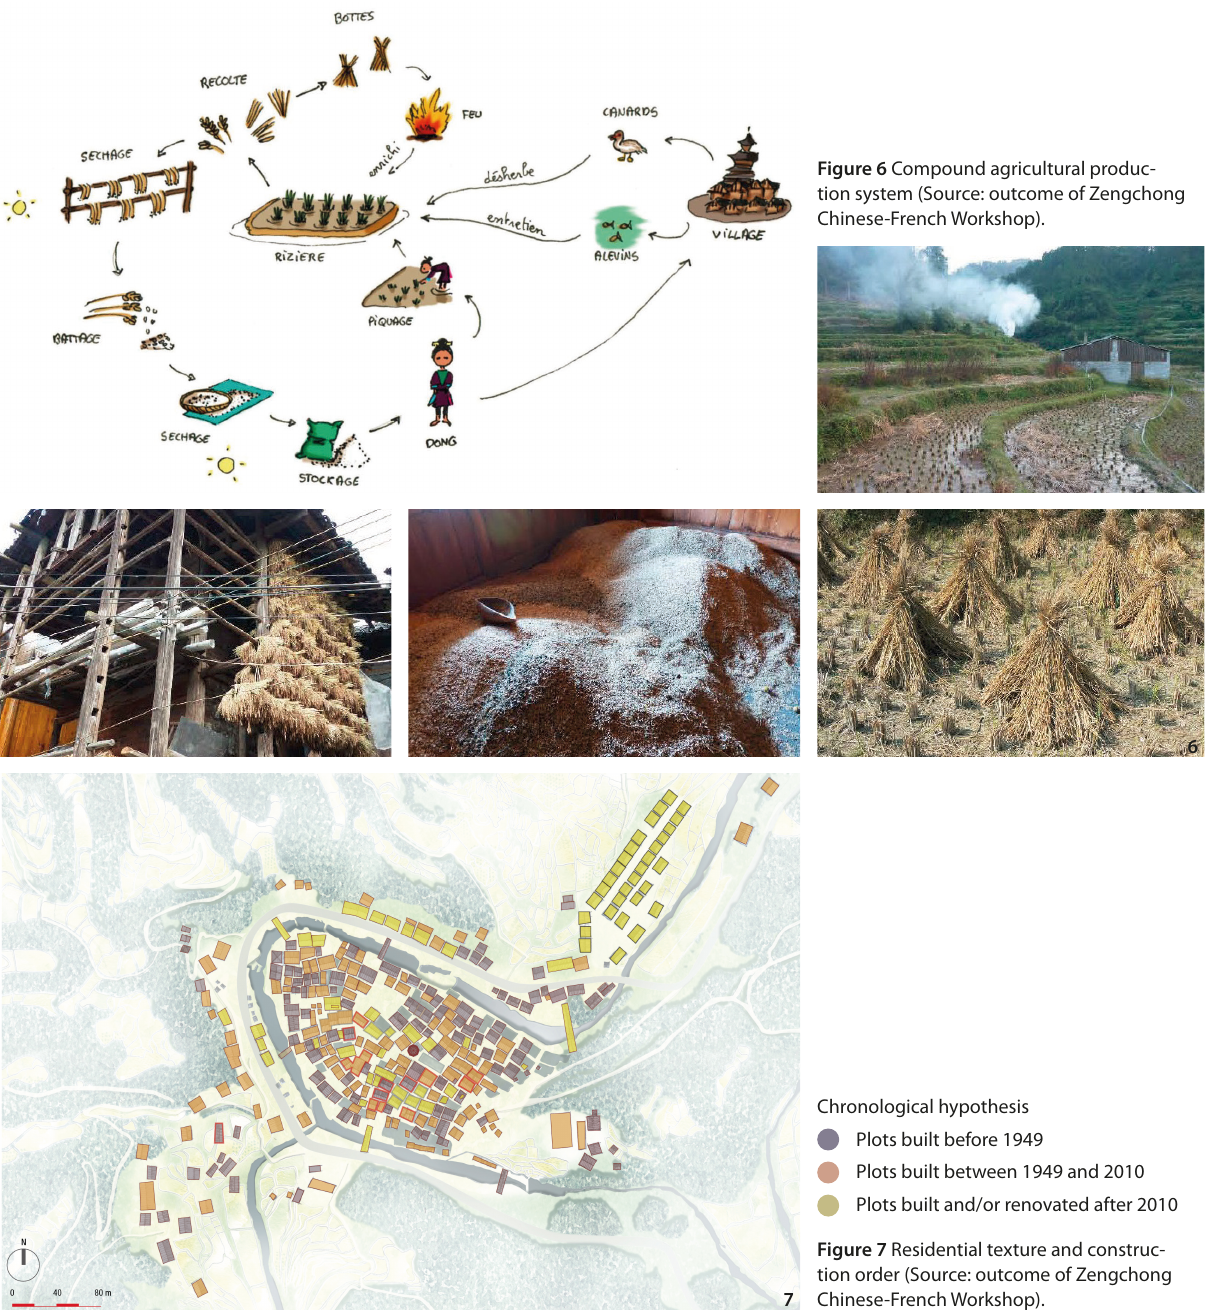
Figure 7 Residential texture and construc- tion order (Source: outcome of Zengchong Chinese-French